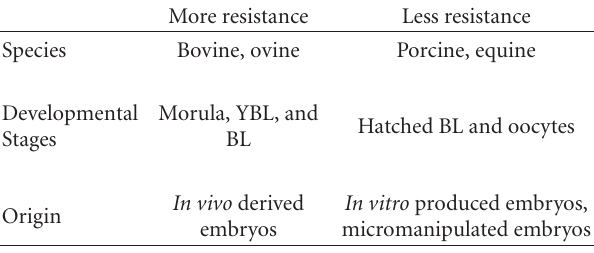
Table 1: Di ff erences of animal oocyte and embryo cryopreservation resistance among species, developmental stages, and